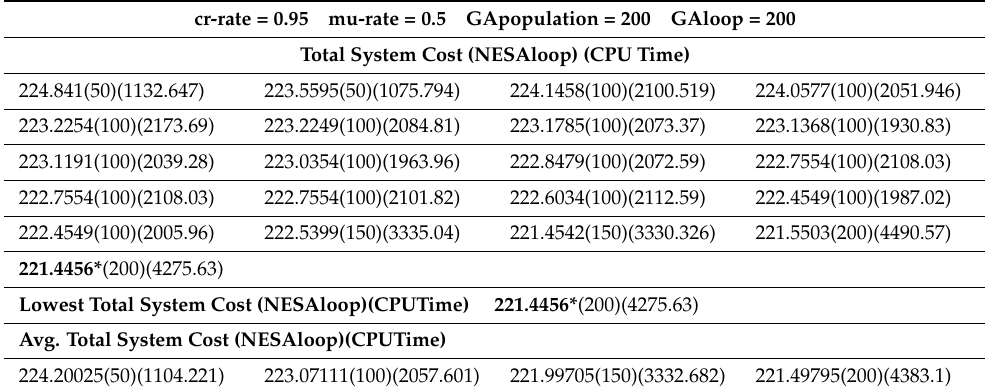
Table 41. The total system costs of 20 simulation runs obtained by NESA–MGA for the n -stage mixed